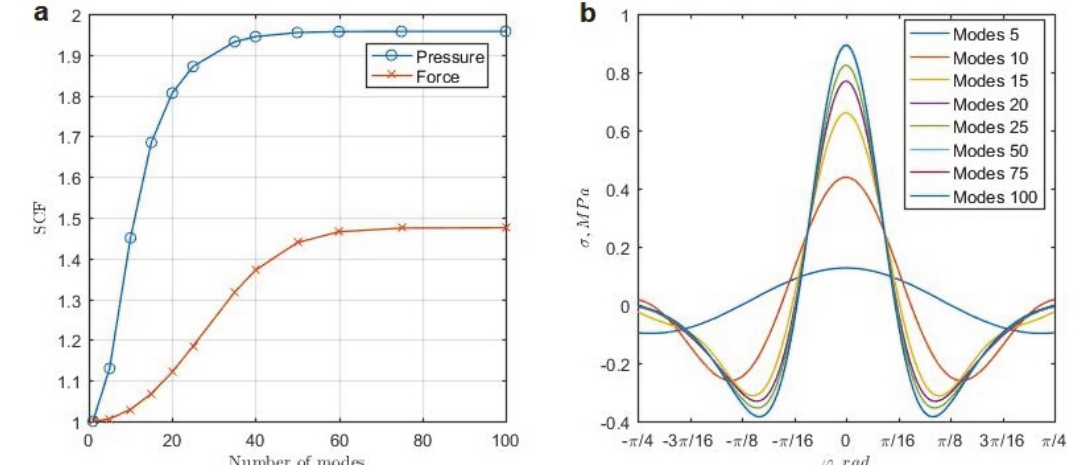
Figure 1: Convergence of results with respect to Fourier terms of expansion: a - stress concentrating factor for pressure and force loading; b – profiles of circumferential bending stress for pressure loading.